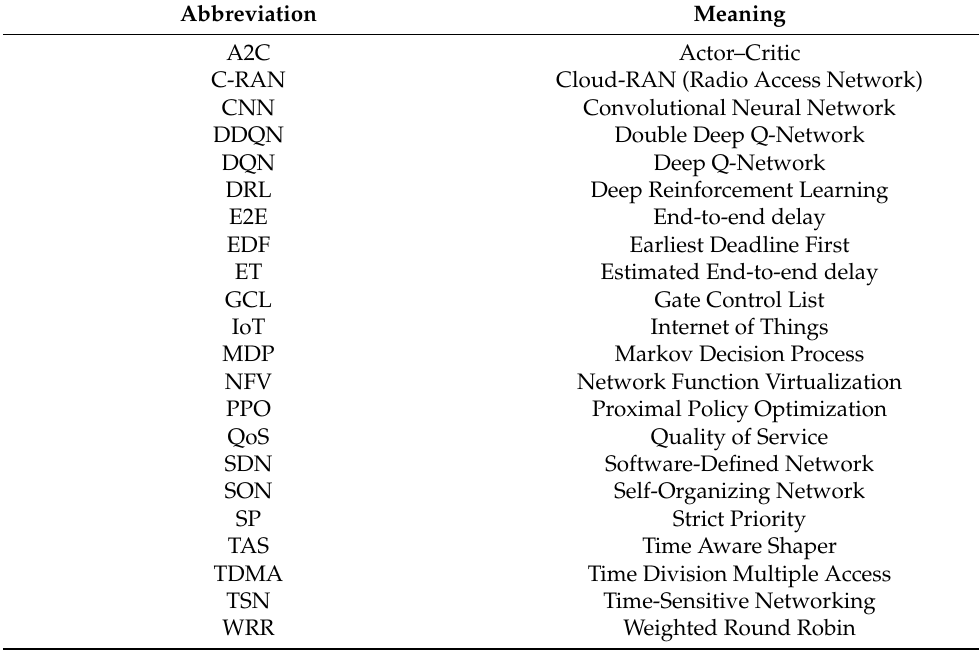
Table 1. Abbreviations used in this